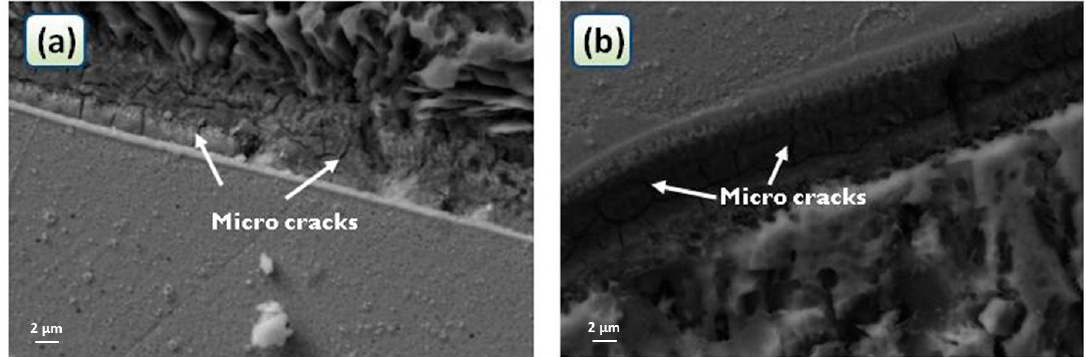
Figure 19. SEM pictures show: ( a ) Close-up of the upper side of the interface of the sample (5000×); ( b ) Close-up of the lower side of the interface of the sample (6000×).